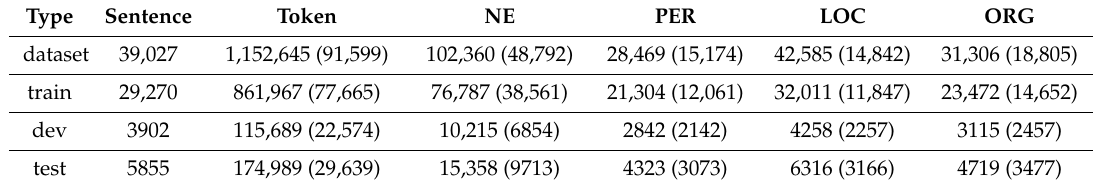
Table 2. Statistics of the entity type for the Uyghur named-entity recognition (NER)